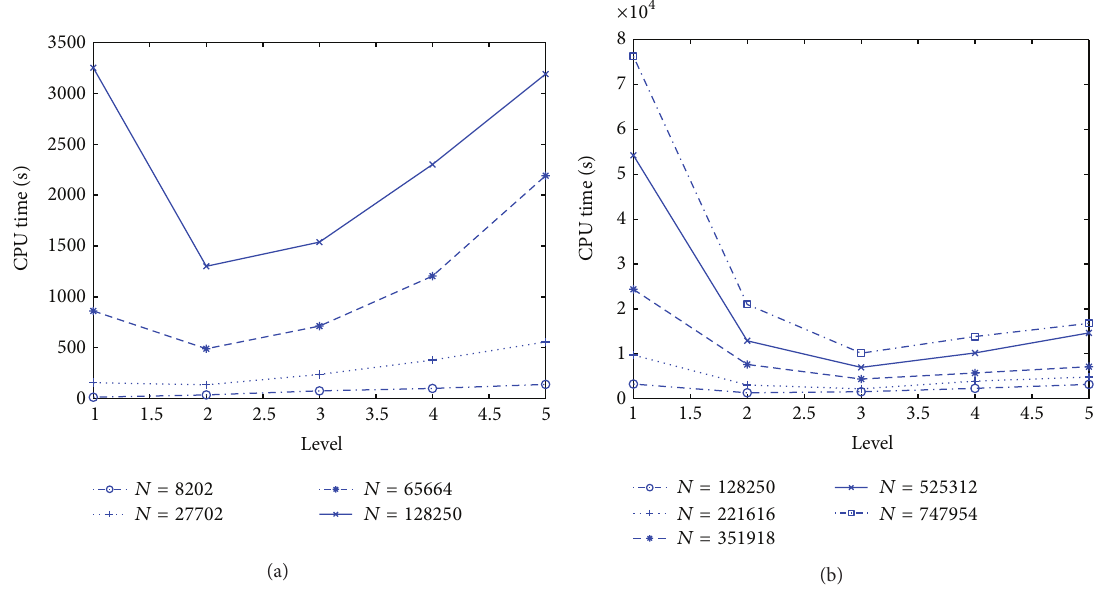
Figure 12: CPU time versus the level for several values of 𝑁 .